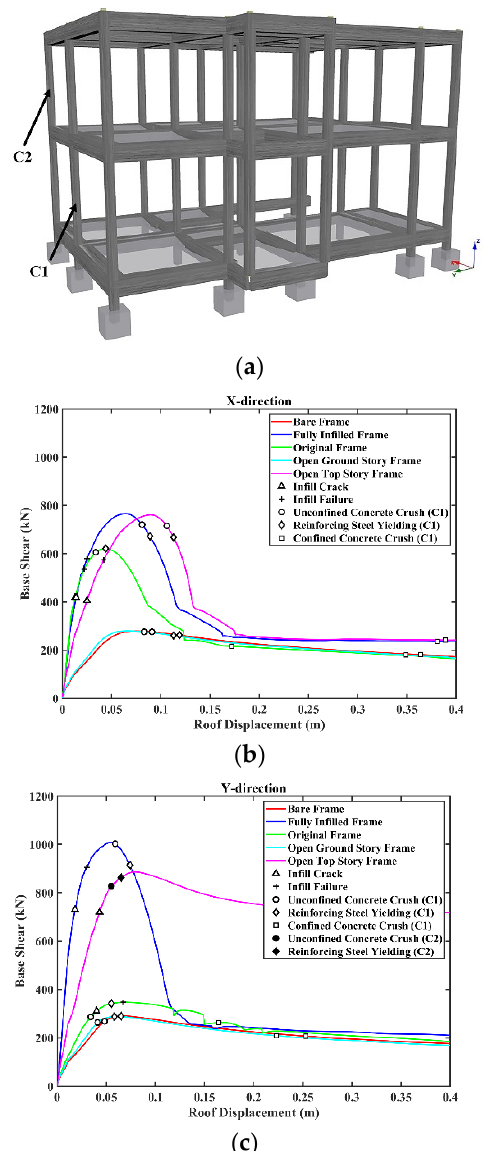
Figure 10. Observed locations and pushover curve of RES: ( a ) Columns C1 and C2; ( b ) x-direction; ( c ) y-direction.